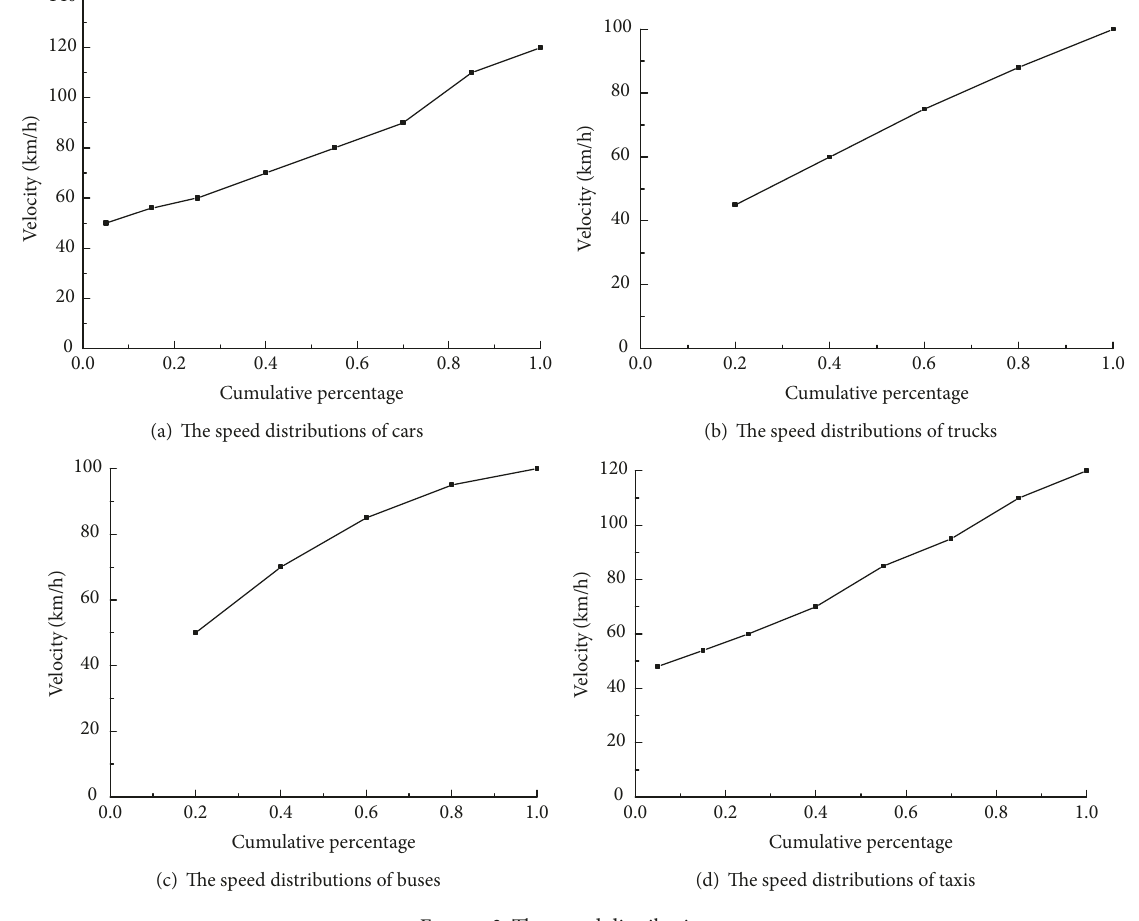
Figure 3: The speed distributions. Table 2: The standard of traffic state classification of a freeway